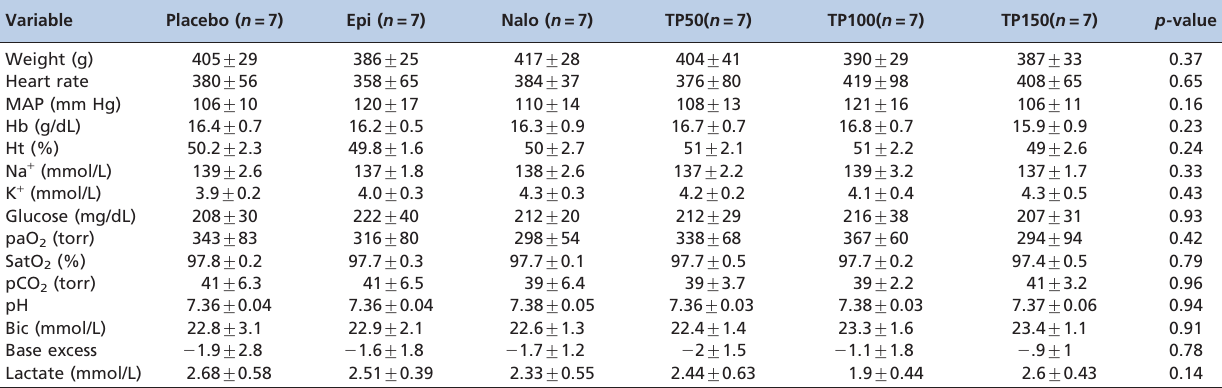
Table 1 - Baseline variables of the different groups Variable Placebo ( n =7)